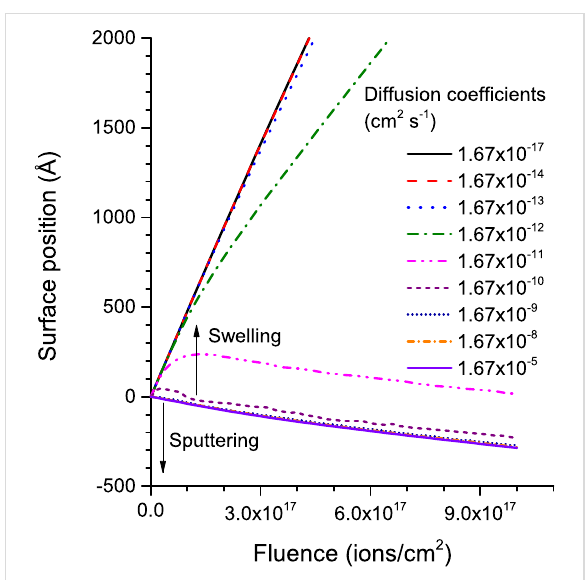
Figure 6: Surface sputtering vs swelling for different diffusion coeffi- cients for helium irradiation of